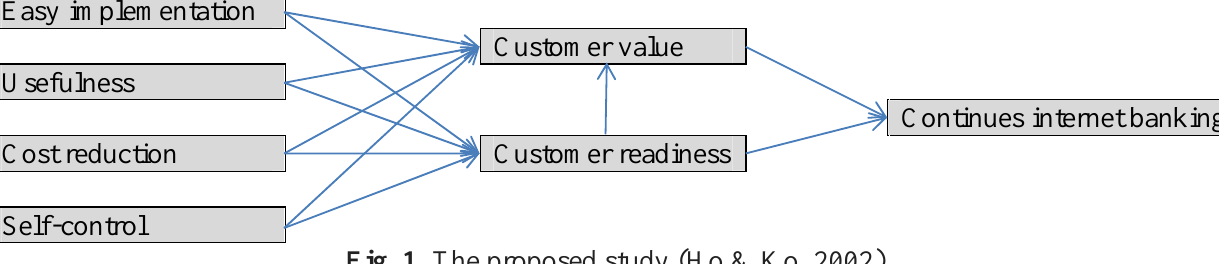
Fig. 1. The proposed study (Ho & Ko, 2002)